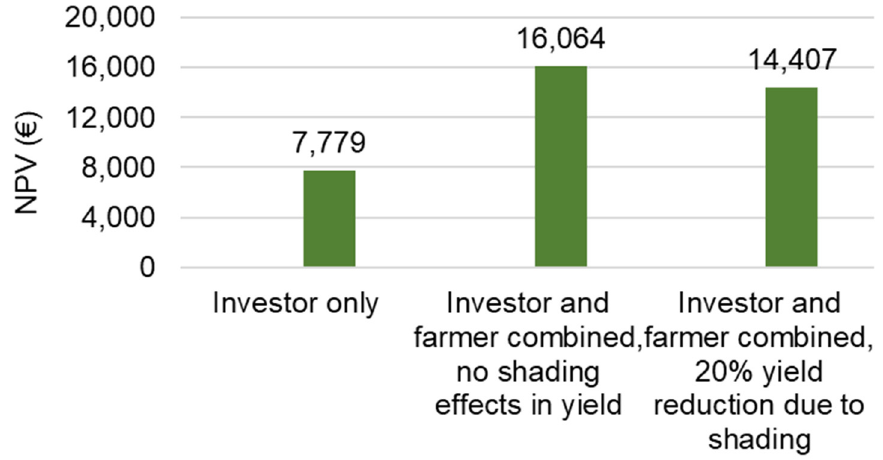
Figure 7. NPVs under different scenarios.